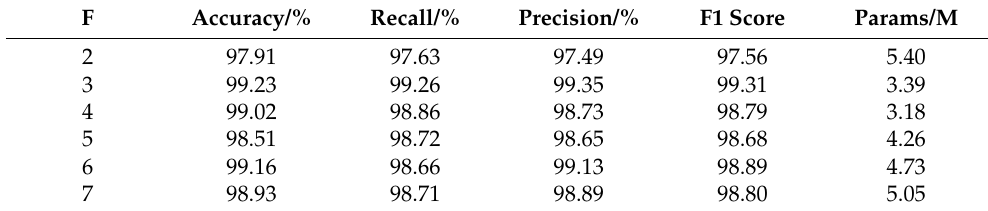
Figure 11. The structure of a tandem of F synthetic structures. Table 2. Influence of the number of series connections on ED Net.